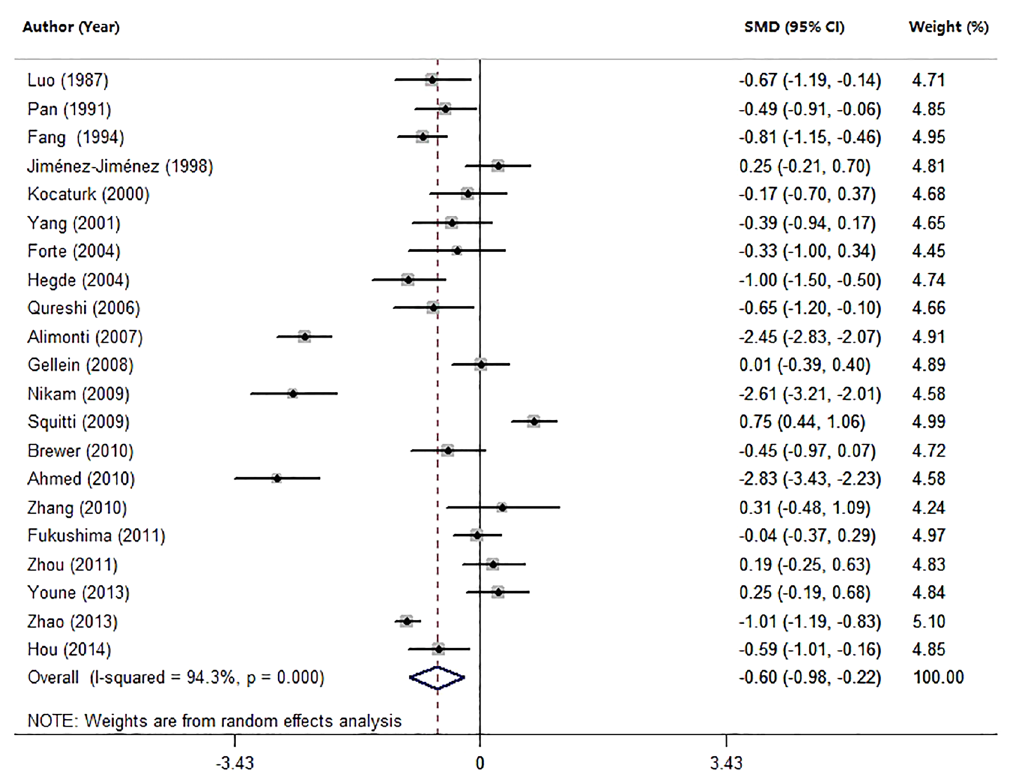
Figure 4. Forest plot for random-effects meta-analysis on differences in serum Zn together with plasma Zn between PD patients and health controls. 21 studies encompassing a sample of 2333 subjects. The horizontal lines represent 95% CI. The sizes of the shaded squares are proportional to study weight. SMD, Standardized mean difference; CI, confidence